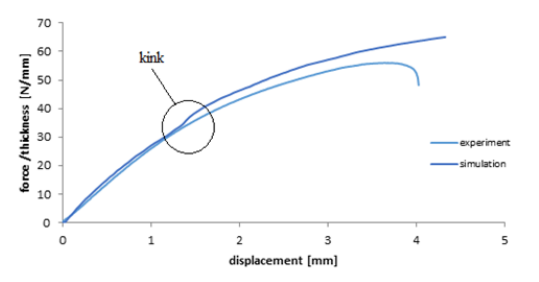
Figure 8. Illustration of kink in curve.